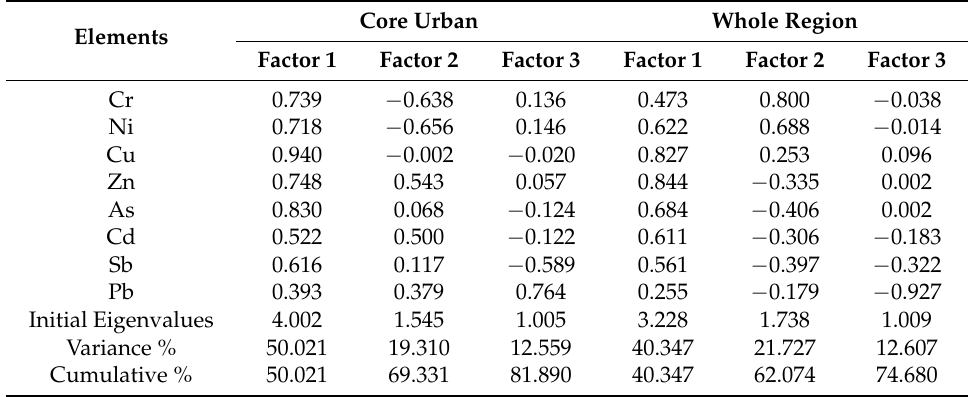
Table 4. Principal component factor scores and eigenvalues of factor loadings in core urban region. Core Urban Whole Elements